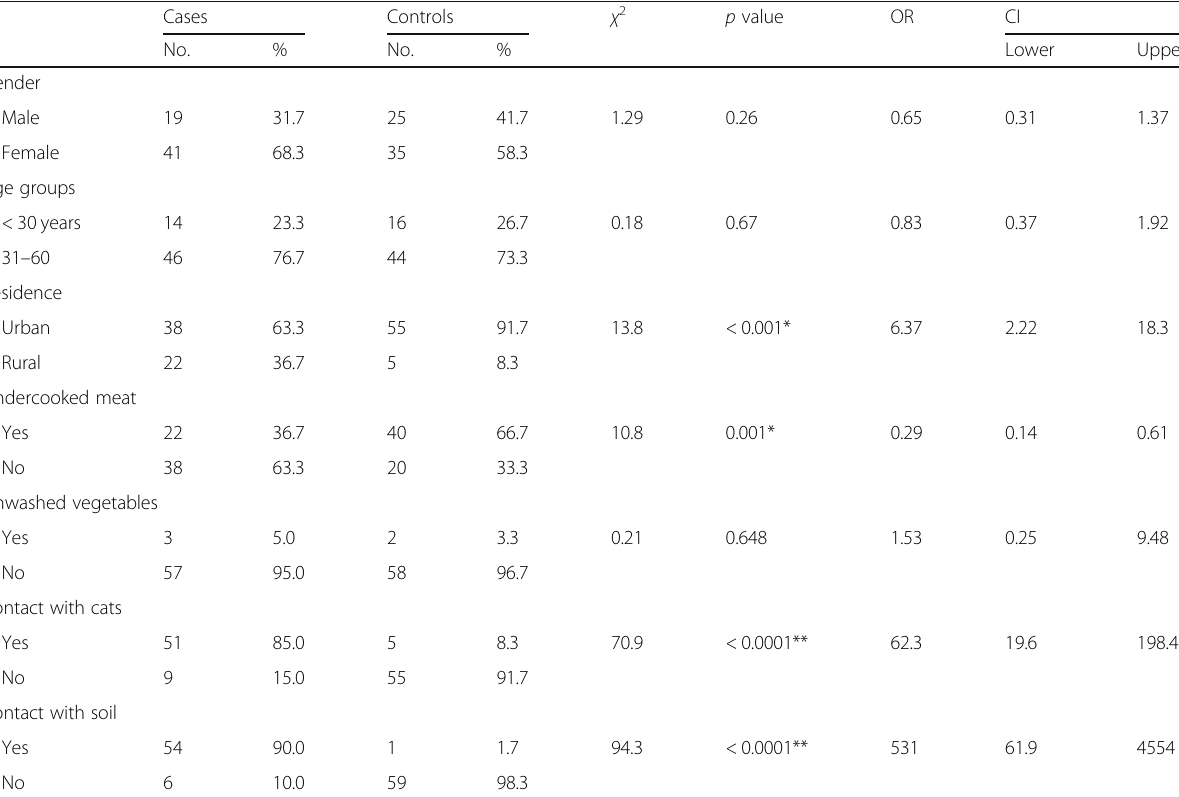
Table 1 Socio-demographic data of patients and